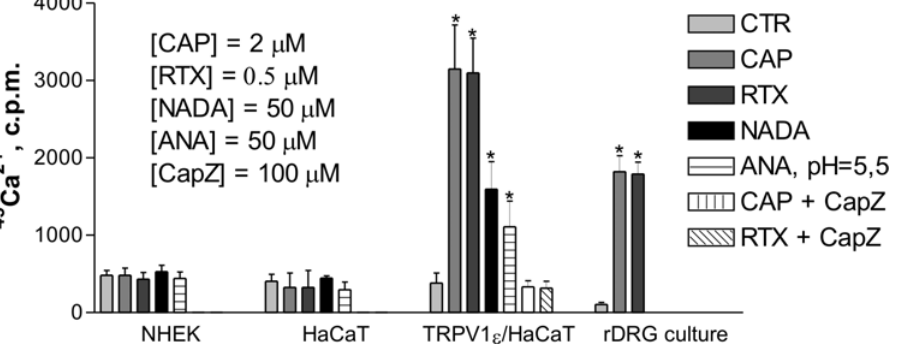
Figure 5. Neither endo-, nor exo-vanilloids caused 45 Ca 2 + -influx in keratinocytes. Primary human keratinocytes (NHEK), primary culture of DRG neurons, HaCaT keratinocytes and TRPV1 transformed HaCat keratinocytes were seeded in 96-well plates, then incubated for 10-min with different TRPV1 agonists (capsaicin, CAP; resiniferatoxin, RTX; N-arachidonoyl-dopamine, NADA; Anandamide, ANA) and combinations of agonists and antagonists (CAP or RTX + capsazepine, capZ) in the presence of 45 Ca 2 + . Cell-bound radioactivity was measured with liquid scintillation. The bars represent mean scintillation counts per minute (c.p.m.) + SD of eight parallel samples from a representative experiment repeated three times with similar results.